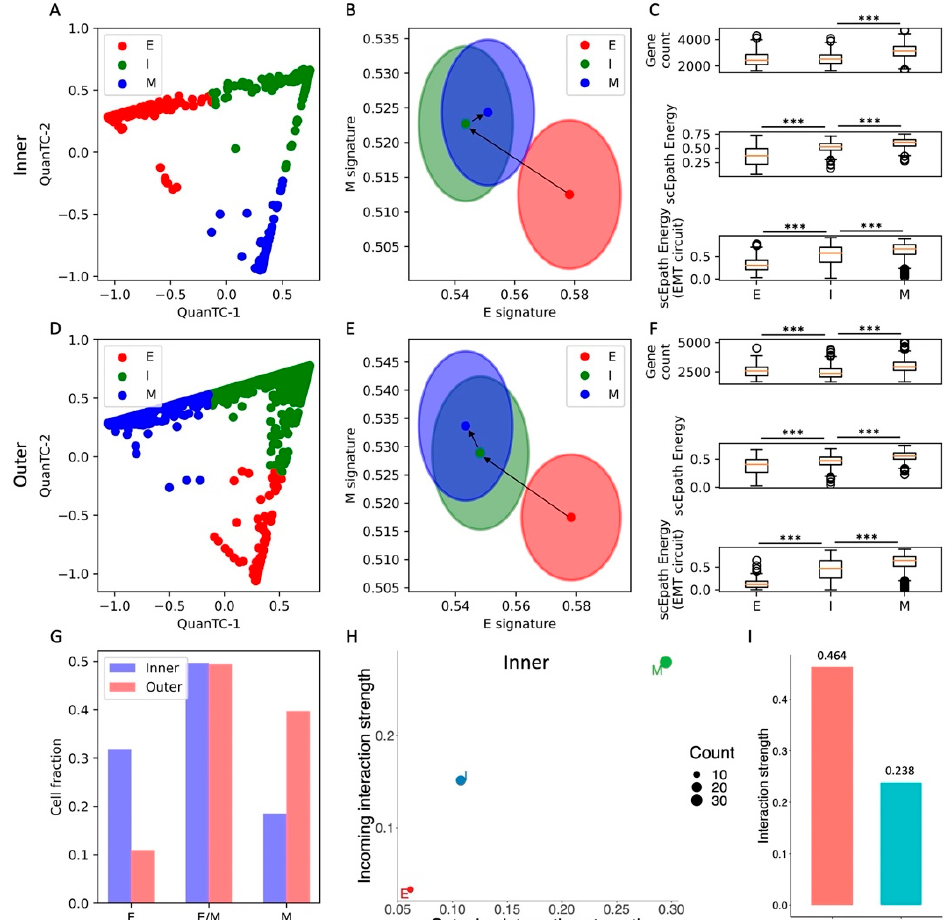
Figure 4. EMT characterization of inner and outer cell populations in a MCF10A 2D cell colony. ( A ) Low-dimensional representation of cells in the MCF10A-Inner dataset. x - and y -axis represent QuanTC coordinates. ( B ) Projection of clusters in the E-M signature space. The centering and radii of each circle represent the average scores and standard deviations of the epithelial and mesenchymal signatures within each cluster. Black arrows show the dominant transition trajectory predicted by QuanTC. ( C ) Boxplots depicting the transcriptional diversity (top), developmental potential (middle), and EMT circuit energy (bottom) in the four clusters. ( D – F ) Same as ( A – C ) for the MCF10A-Outer dataset. ( G ) Comparison of cell fractions belonging to the E, I, and M clusters in the inner and outer datasets. ( H ) Low-dimensional projection of cell clusters from the inner dataset in an incoming/outgoing signaling strength space computed with CellChat. ( I ) Comparison of total interaction strengths between the inner and outer datasets. This quantification considers all clusters and all signaling pathways. *** indicates p -value < 0.001 on a one-tailed t -test. Overall, analysis of the MCF10A inner and outer datasets highlights agreement be- tween EMT progression, systems-level measures of stemness, and EMT circuit